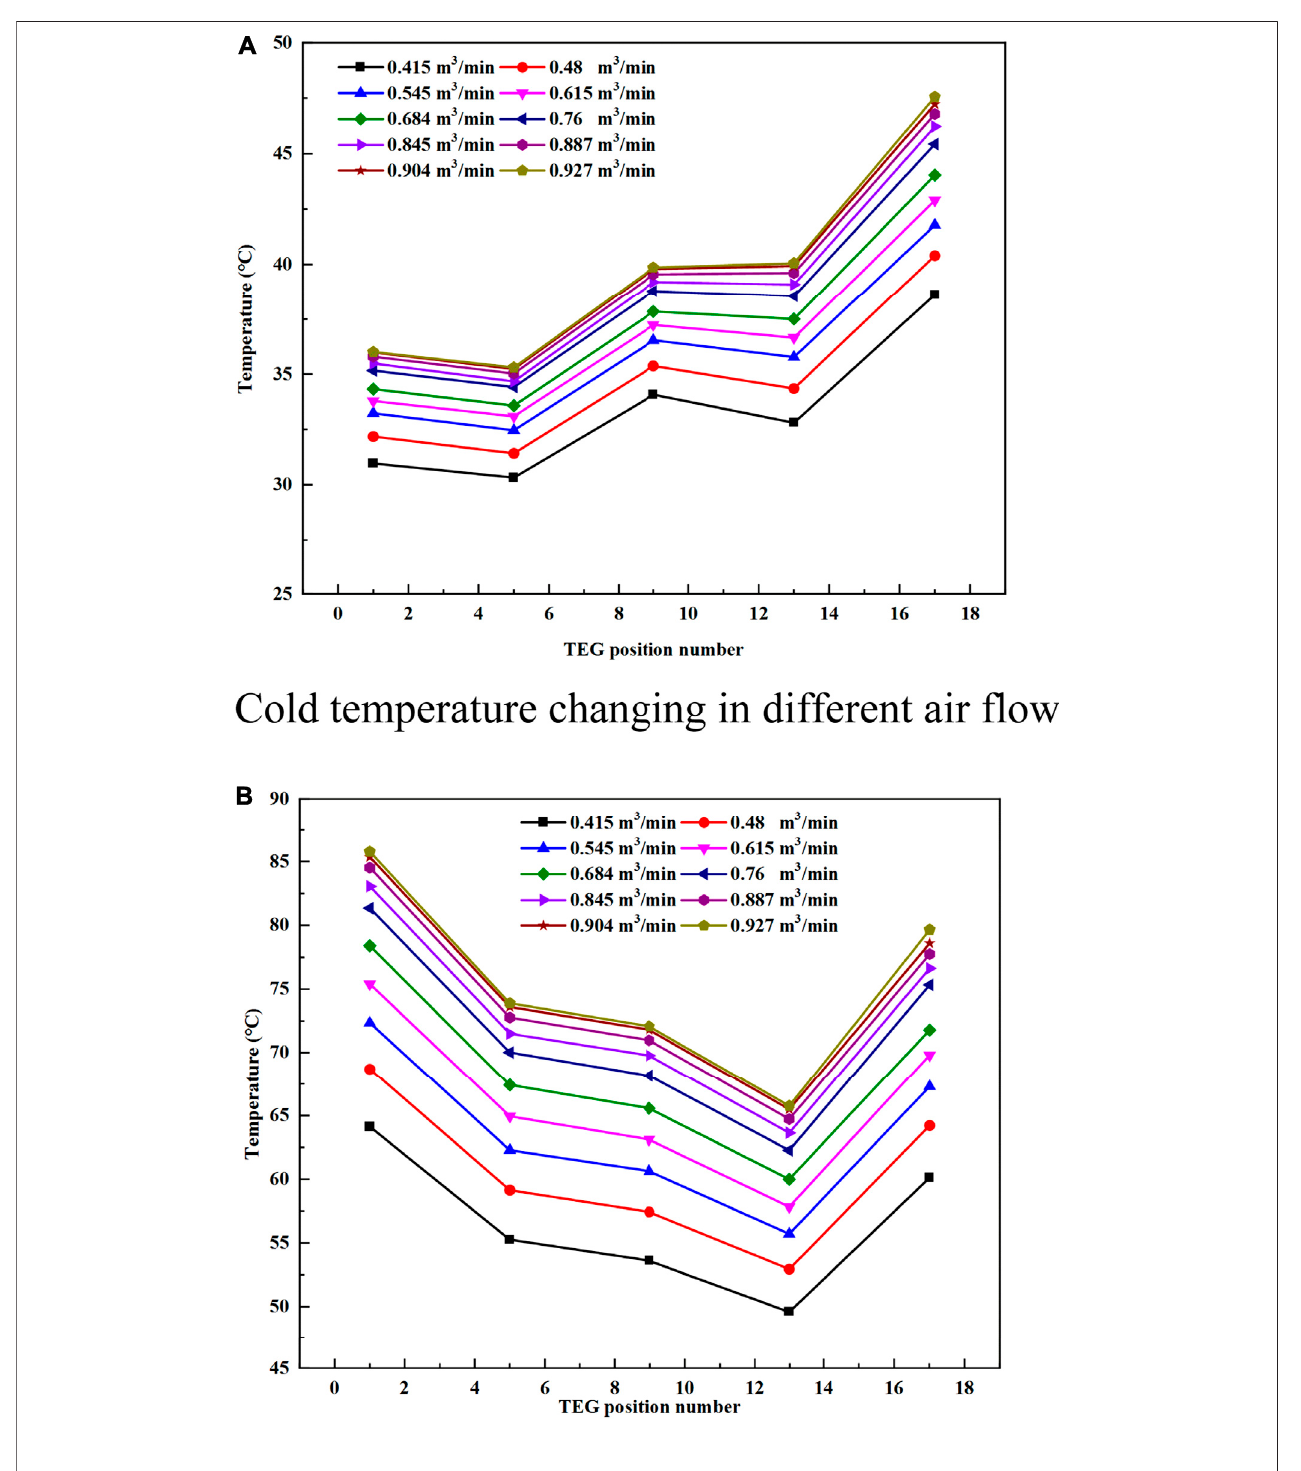
FIGURE 9 | (A) Cold temperature changing in different air fl ows. (B) Hot temperature changing in different air fl ows.